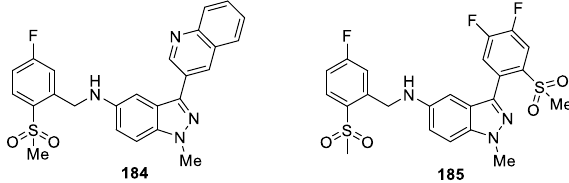
Figure 62. Chemical structures of 1 H -indazole derivatives 184 and 185 .